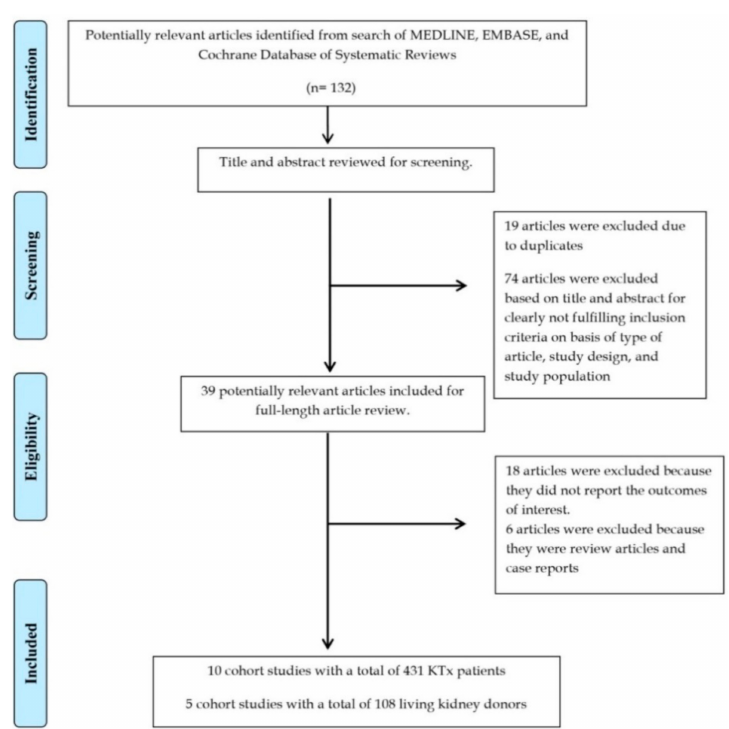
Figure 1. Outline of our search methodology. Abbreviation: KTx, kidney